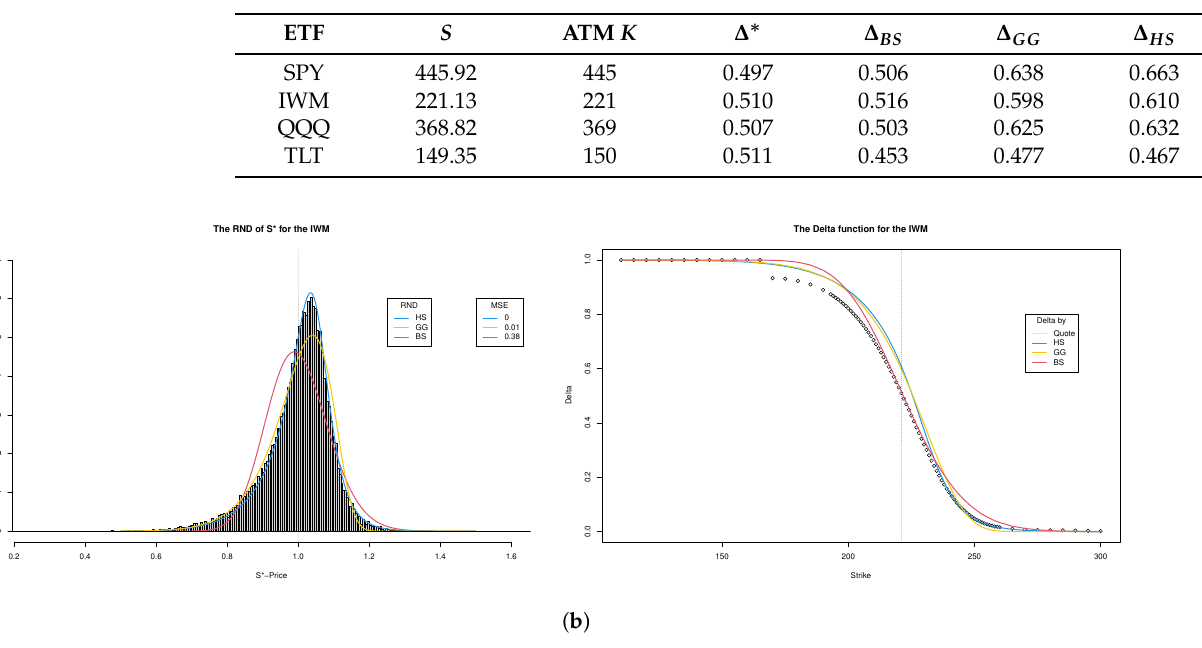
Figure 4. The IWM case: ( a ) the HS, GG and BS implied RNDs along with the Monte Carlo distribution of the Spot’s price S ∗ , and ( b ) the corresponding delta functions along with the quoted delta per each strike K in the option